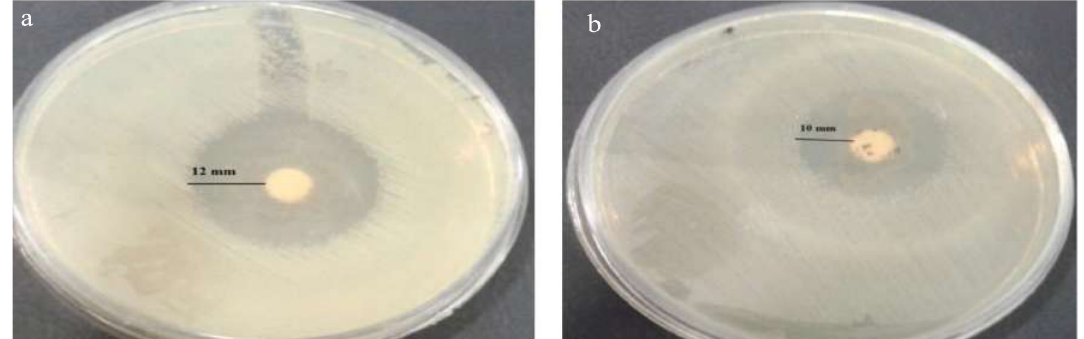
Fig. 9. The antibacterial activity of chitosan/PEO/1wt%cefazolin nanofibers in the presence of; a) S.aureus and b) E.coli